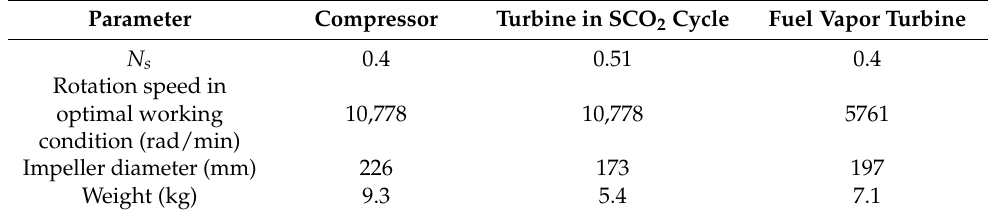
Table 8. Weight and dimensional design of